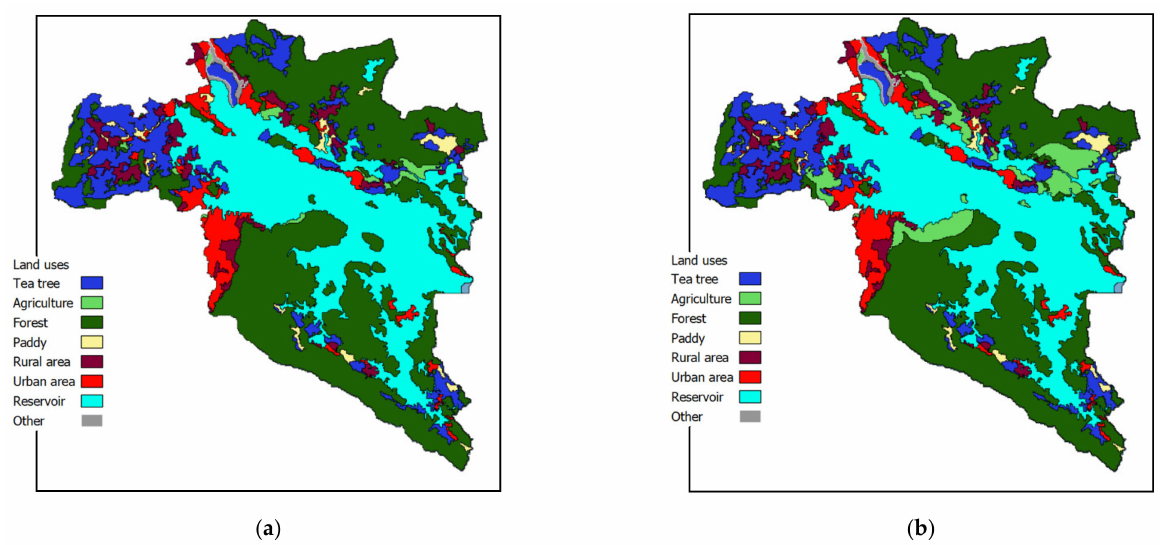
Figure 9. Transition from forest to agricultural areas surrounding the reservoir, under S2 ( a ) and S3 ( b